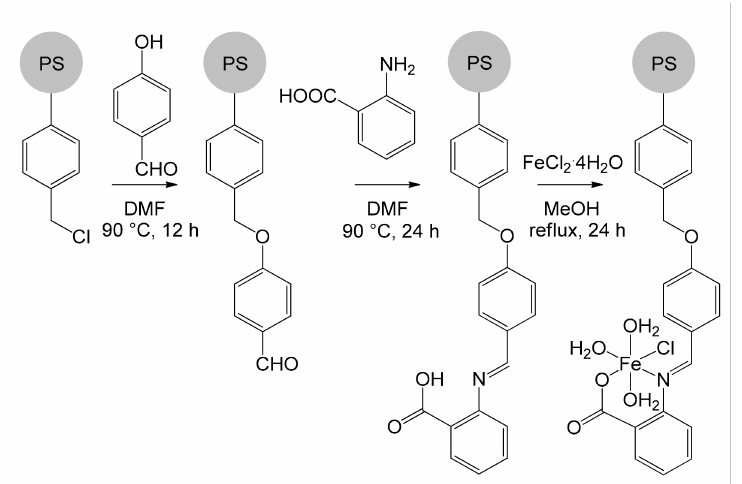
Figure 11. Synthesis of the catalyst [Fe II (Antra-Merf)] immobilized over a PS Merrifield resin